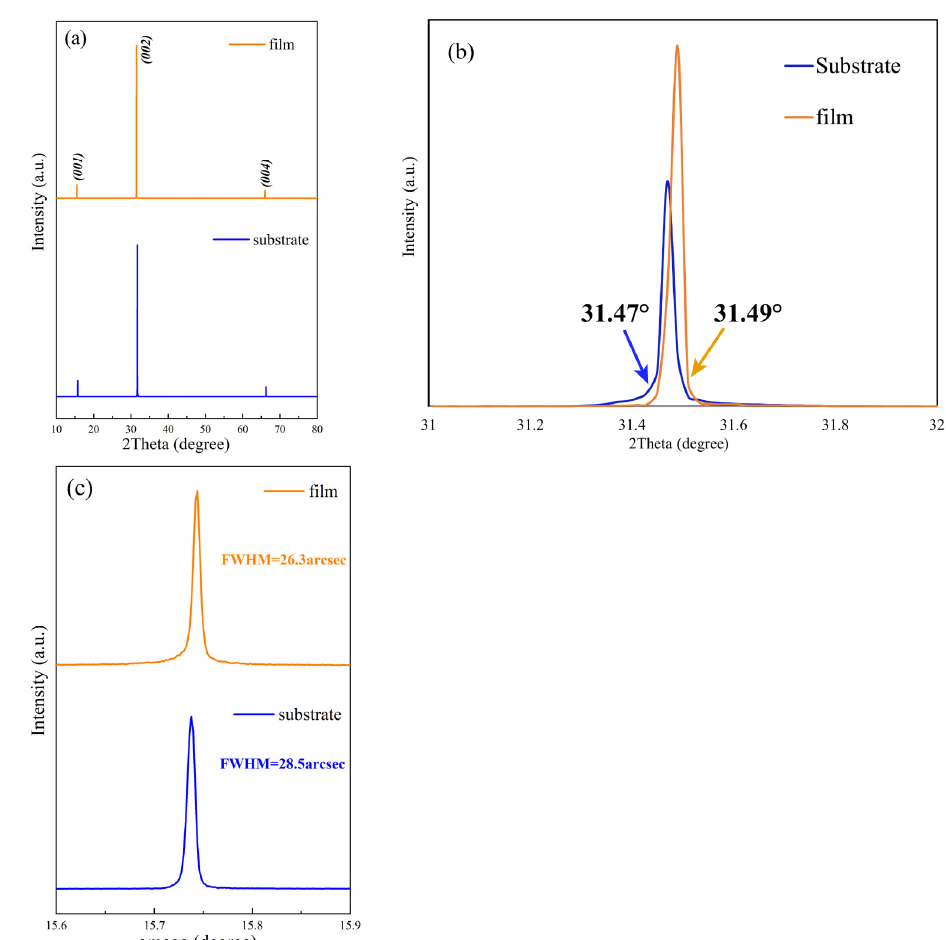
Figure 1. XRD patterns of β -Ga 2 O 3 substrate and film; ( a ) 2theta-omega patterns in the range of 10°~80°; ( b ) 2theta-omega patterns of (002) diffraction plane; ( c ) rocking curve of (002) diffraction plane.